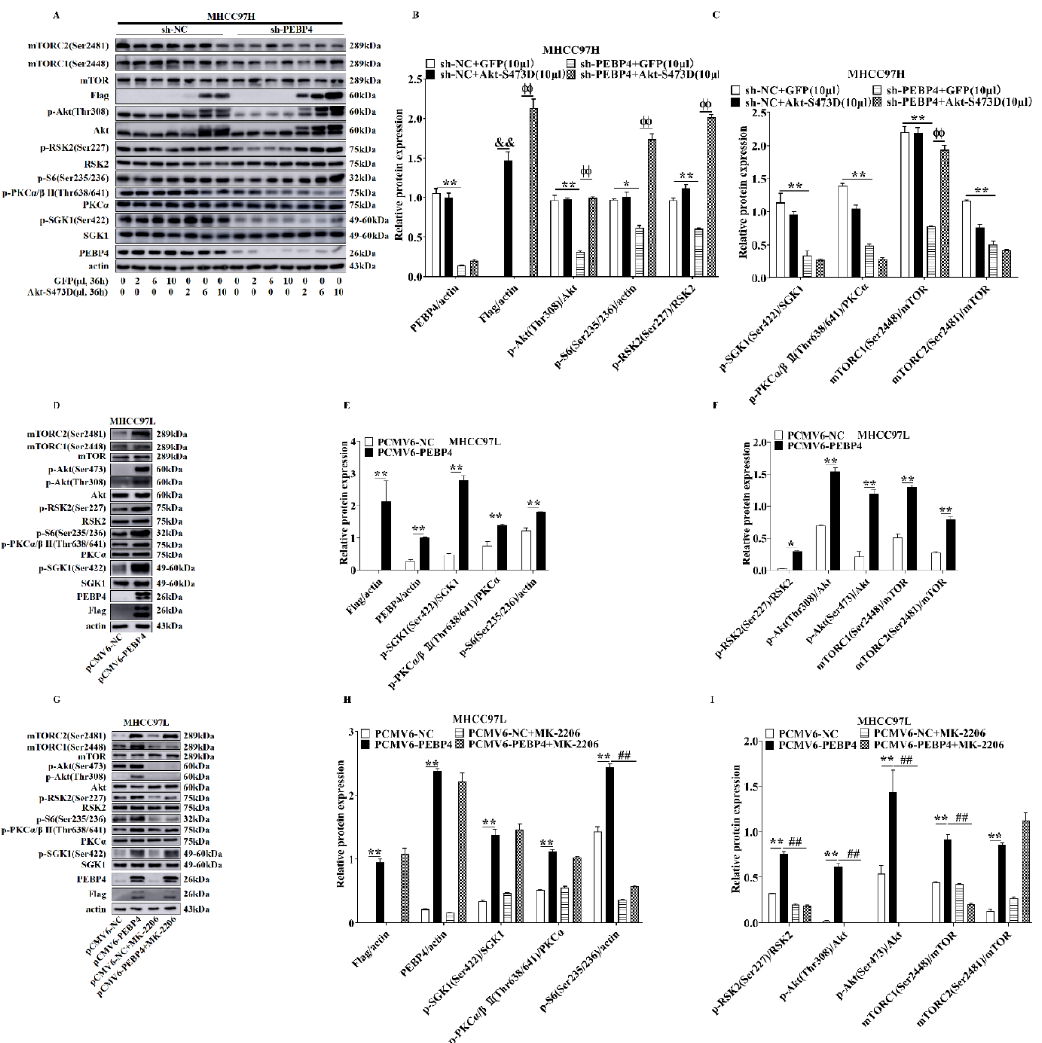
Figure 2. Akt in mediating the effect of PEBP4 on mTORC1, but not mTORC2. ( A ) The MHCC97H cells containing sh-PEBP4 or sh-NC were infected with adenovirus encoding the active Akt1 mutant (Akt-S473D) or GFP as a control at different doses and Western blots carried out using antibodies, as indicated. ( B , C ) The immunoblotted bands were analyzed by densitometry, as in Figure 1. ( D , G ) The MHCC97L cells containing pCMV6-PEBP4 or pCMV6-NC were treated with or without MK-2206 (5 µM,24 h), an Akt specific inhibitor, and extracted blotted with antibodies. ( E , F , H , I ) Quantification of bands in ( D , G ) was performed. Results were presented as mean±SEM (n = 3). Significant differences were examined by student’s t -test. * p < 0.05, ** p < 0.01, ## p < 0.01, && p < 0.01, φφ p < 0.01.